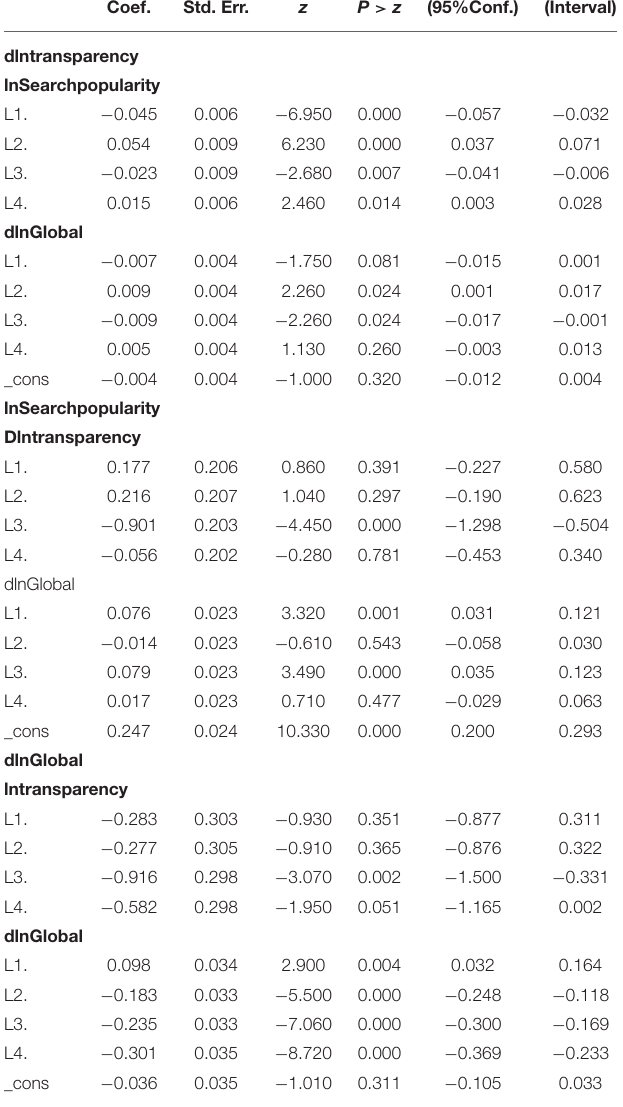
TABLE 5 | VAR estimations for accounting transparency, fear sentiment, and global daily new patient.